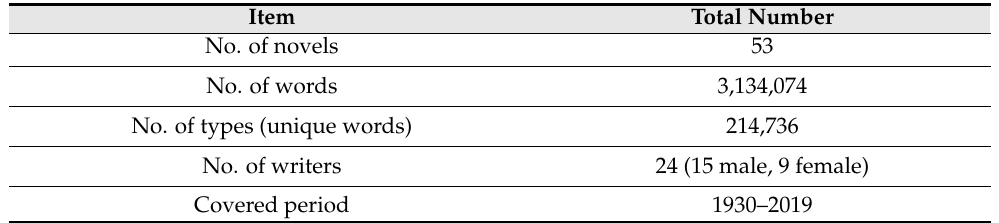
Table 1. The basic statistics of the